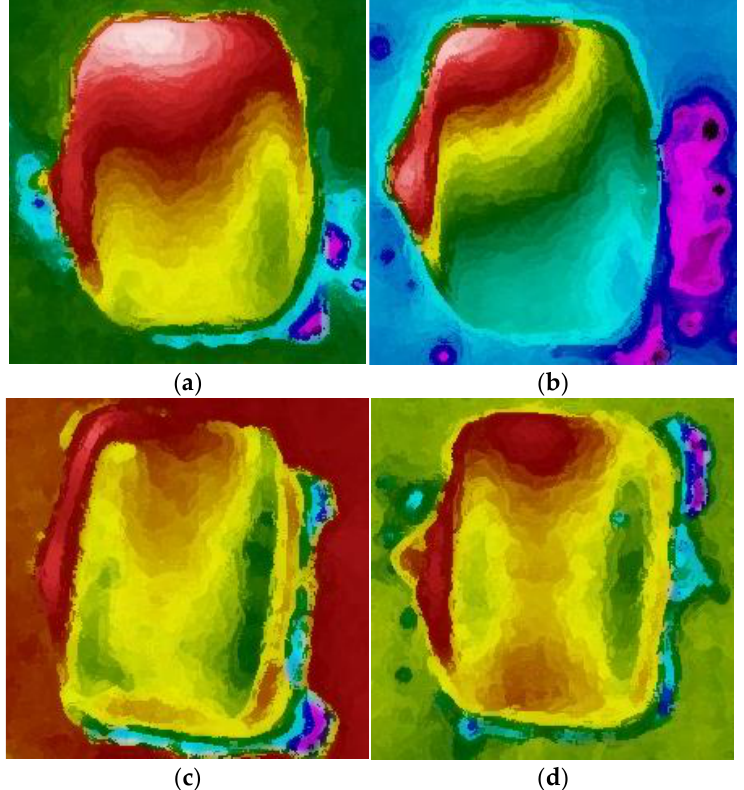
Figure 12. Briquette thermograms showing the temperature gradient across its surface: ( a ) M1, ( b ) M2, ( c ) M3, and ( d ) M4.